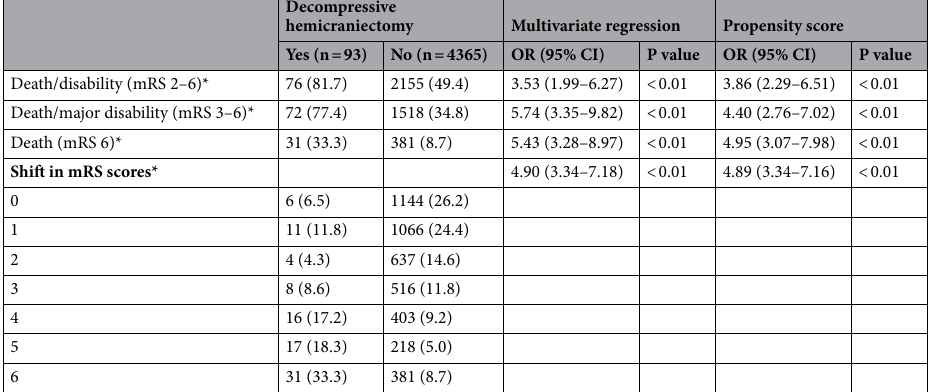
Table 4. Decompressive hemicraniectomy and clinical outcomes at 90 days. CI confidence interval, mRS modified Rankin scale, OR odds ratio. *The mRS evaluates global disability; scores range from 0 (no symptoms) to 6 (death). A score of 2 to 5 indicates some degree of disability.